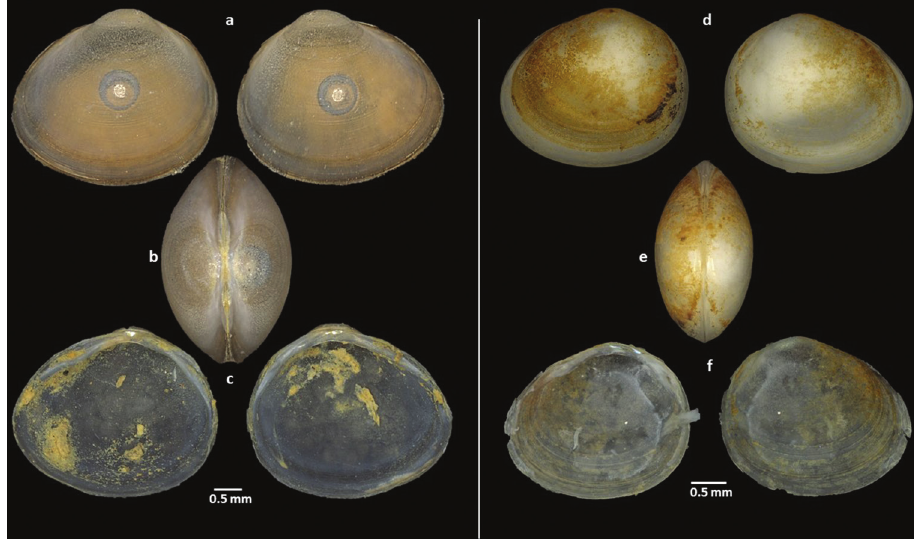
Figure 3. Two specimens of P. subtruncatum from Ait M’hamed cave a, d external view of the shell of the left and right sides of both specimens b, e dorsal view of both specimens c, f internal view of left and right valves of both